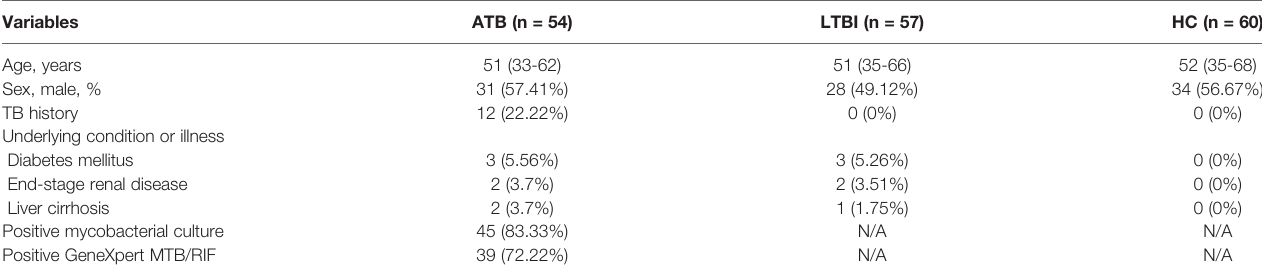
TABLE 1 | Demographic and clinical characteristics of included